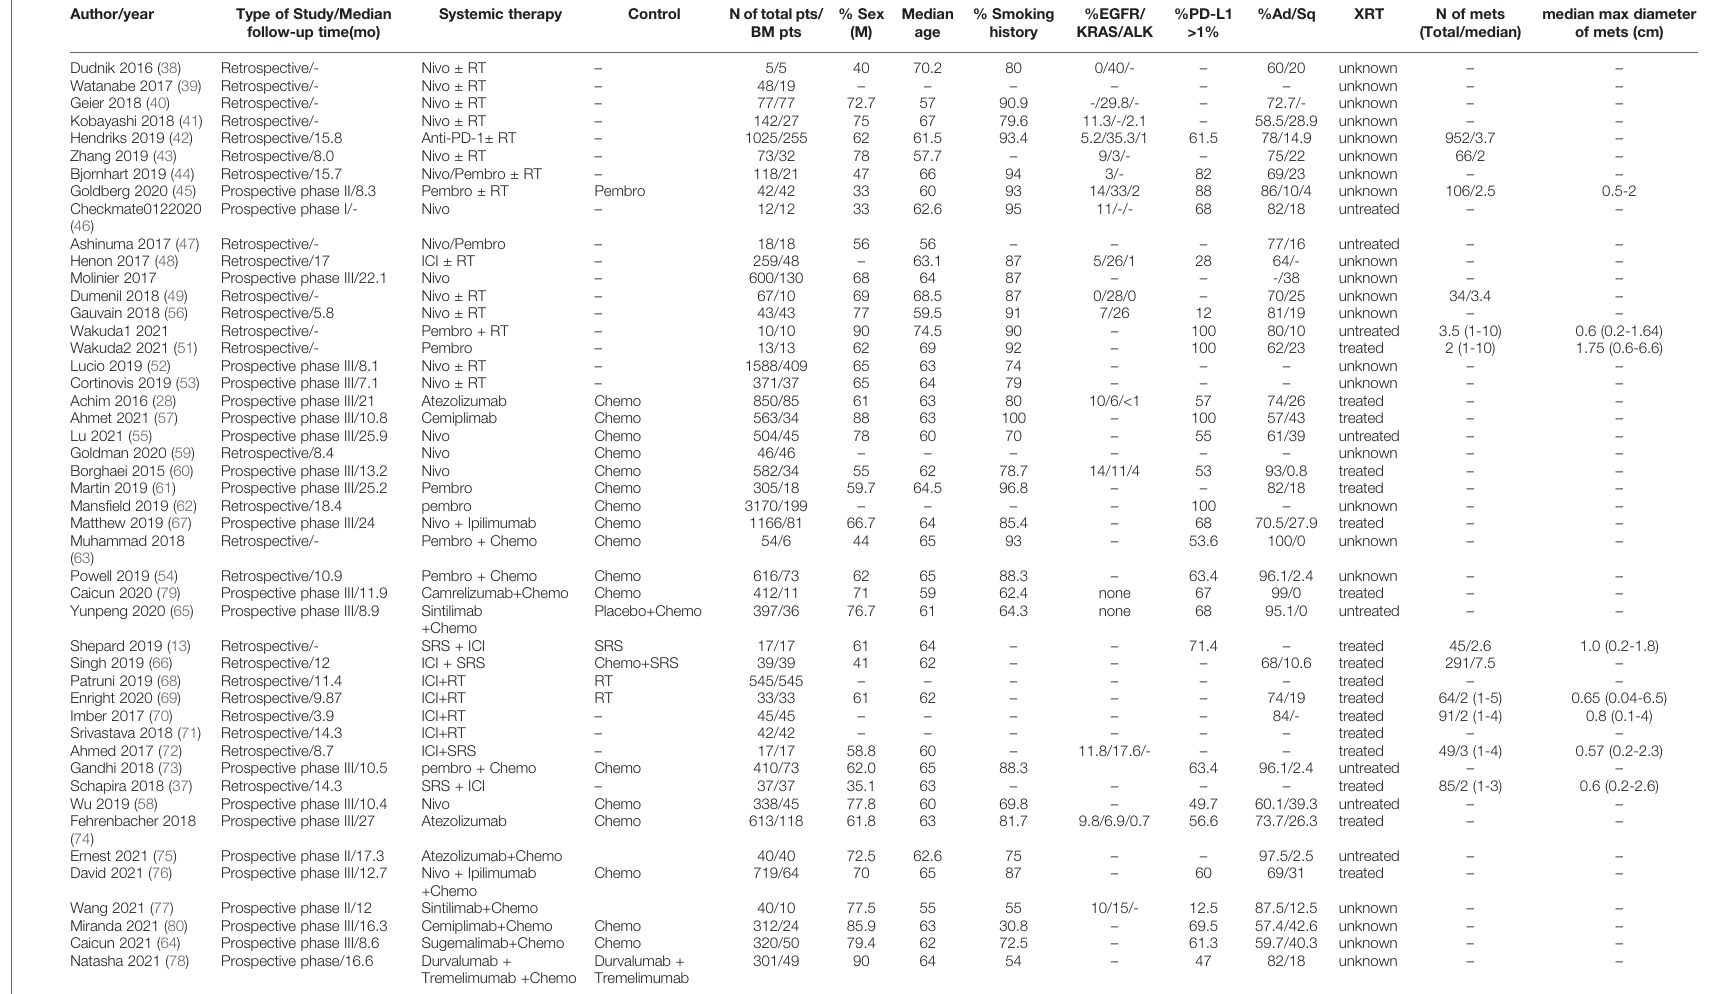
BM,brainmetastases;F,female;mo,months;pts,patients;N,number;ICI,immunecheckpointinhibitors;Nivo,nivolumab;Pembro,pembrolizumab;Chemo,chemotherapy;q2w,everytwoweeks;q3w,every3weeks;Ad,adenocarcinoma; Sq, squamous-cell carcinoma; SRS, stereotactic radiosurgery; con, concurrent; seq,